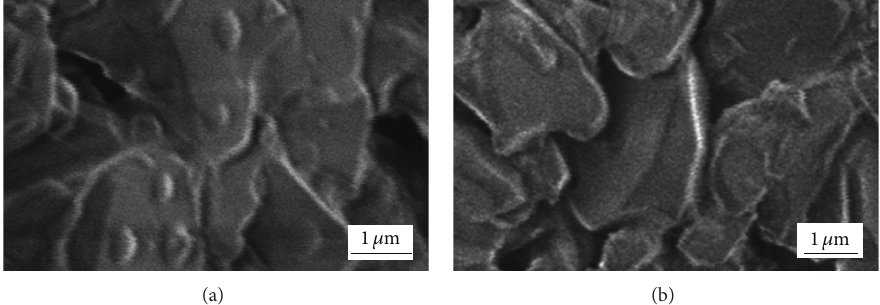
Figure 8: SEM micrographs of Ni-Pd on the foam surface, obtained after reduction of chloride precursors at 533 K, Ni loading: (a) 5 wt% and (b)